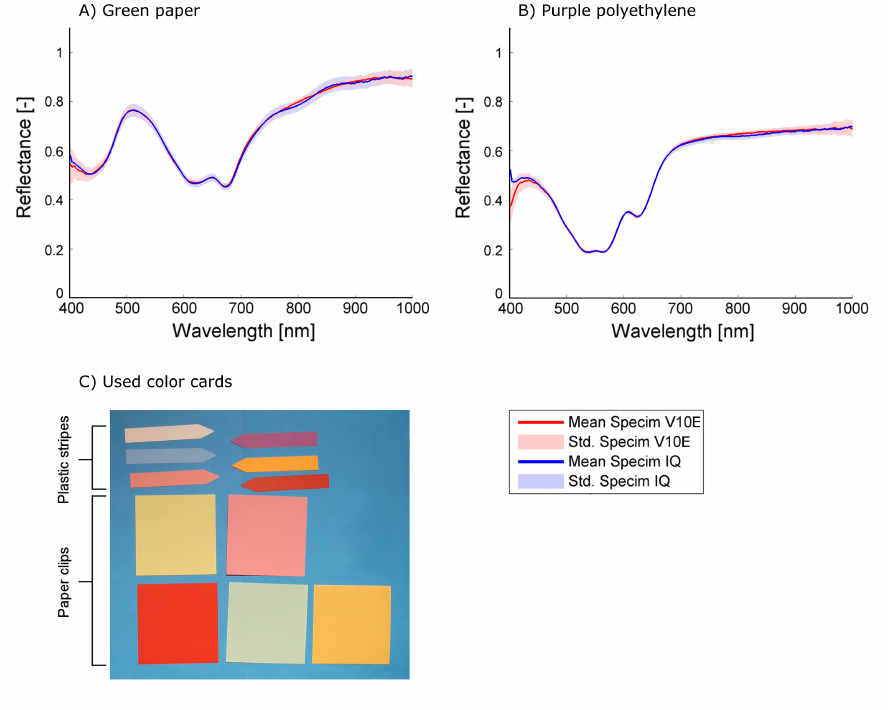
Figure 3. The mean spectra including the standard deviation of green paper ( A ) and purple polyethylene ( B ) as representatives of the observed reference objects of different color in the indoor setting ( C